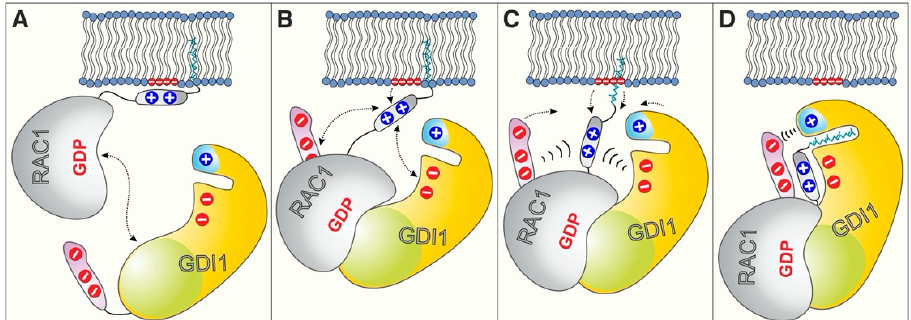
Figure 5. Schematic models of GDI1-regulated RAC1 extraction from the cell membrane. ( A ) GDI1 SWBD (green) recognizes and binds the switch regions of RAC1 to initiate its extraction from the membrane. ( B ) This step is followed by the electrostatic attraction of RAC1 polybasic region through the negatively charged GGBD (orange) and probably also NTA (purple). ( C ) NTA and GGBD are integral elements of the electrostatic pincer function, creating intermolecular charge attraction forces towards positively changed HVR. ( D ) This electrostatic steering mechanism rounds off the GDI1- mediated RAC1 extraction from the membrane by locking the geranylgeranylated C-terminus of RAC1 through the terminal charged regions of GDI1, and safeguarding RAC1 GG -bound state of the GDI. Coloring is the same as the coloring of GDI1 and RAC1 structures shown in Figure 2D,E. Positive charges are schematically shown as + and negative electrostatics as -. For more details, see the discussion and conclusions.